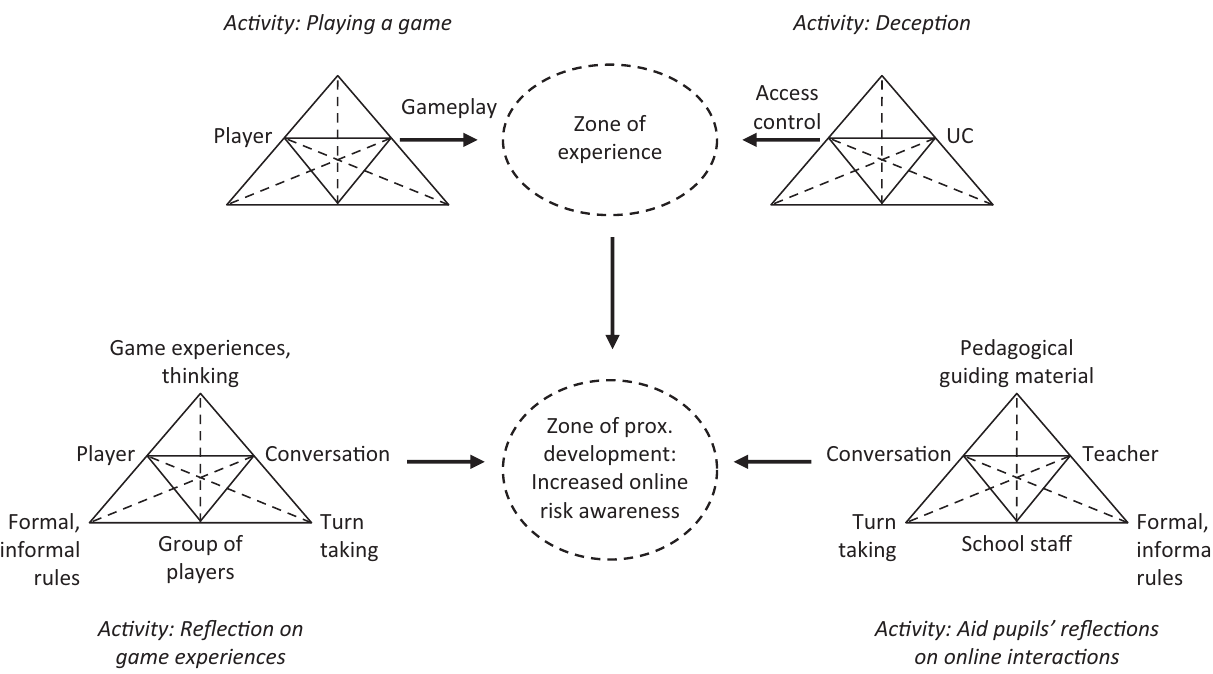
Figure 6. The zone of experience is a foundation for the ensuing follow-up conversation in the zone of proximal develop- ment, where players and teacher reflect on the gaming experience in relation to online